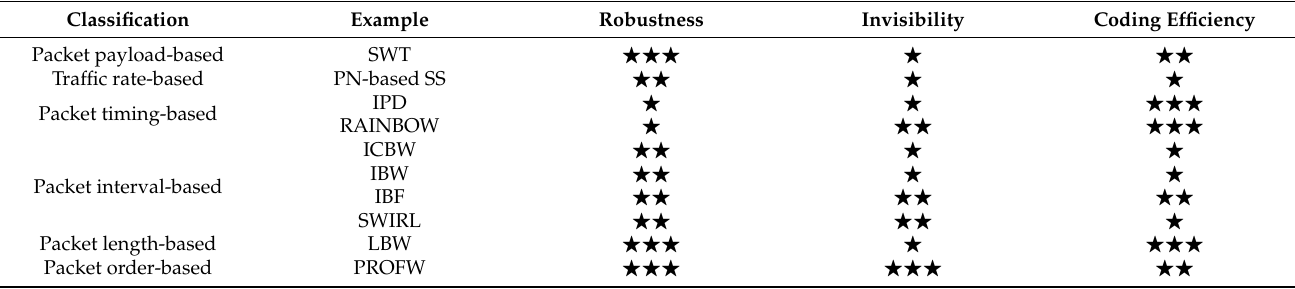
Table 2. Evaluation of several flow watermarking